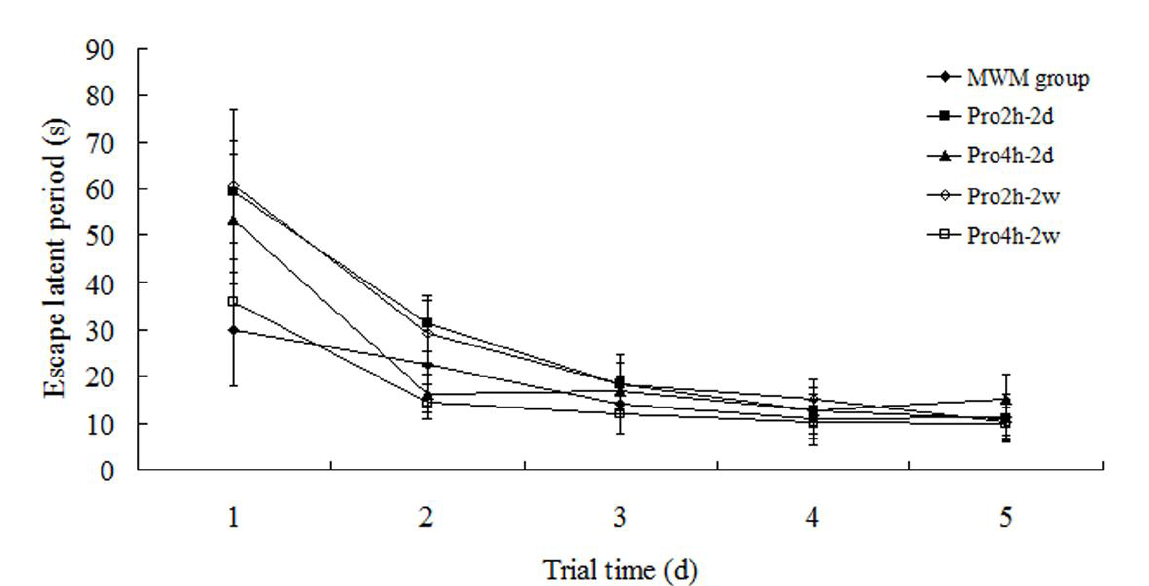
FIGURE 1 - Morris water maze training in young rats treated with propofol. Comparing with MWM group, the performance of young rats treated anesthesized by propofol of either 2h or 4h was not significantly impaired. The escape latent period was stable after day 3